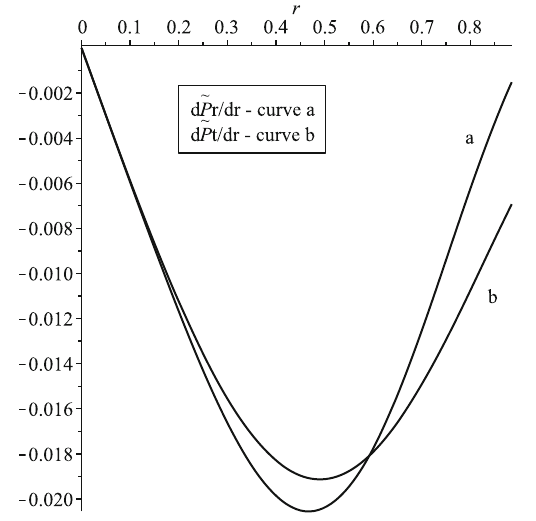
Fig. 1 Pressures for the solution obtained with the first algorithm with F = 0 from the isotropic Gold III solution